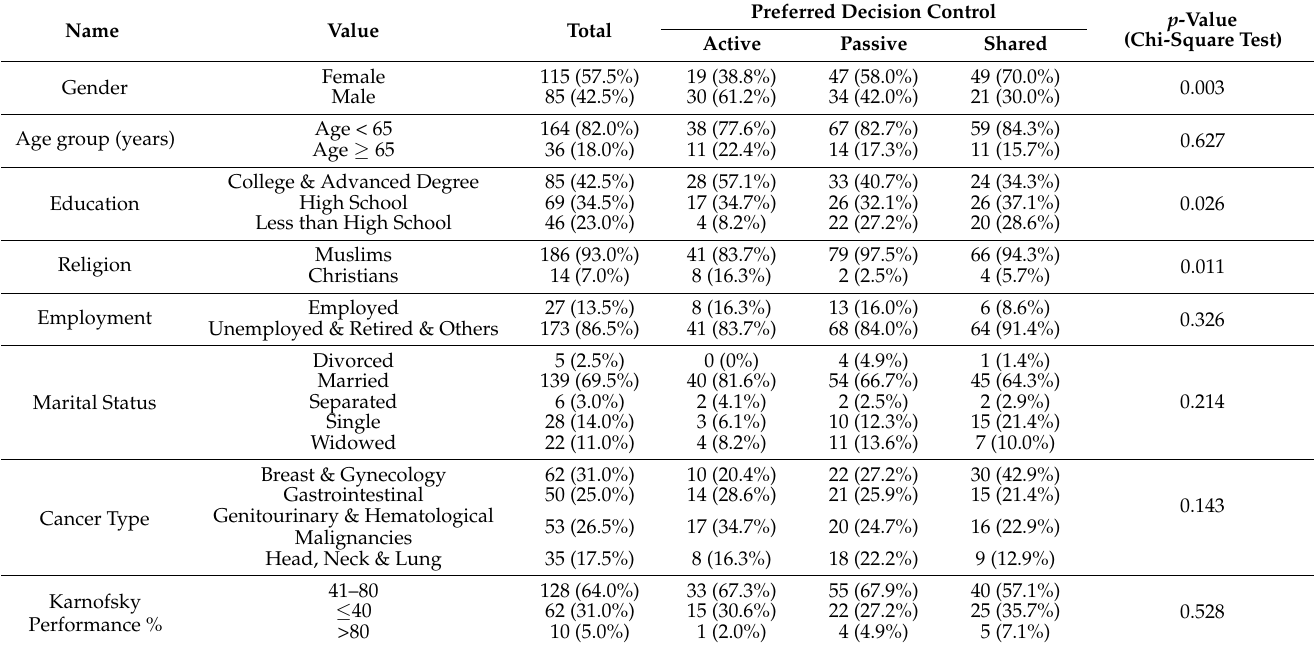
Table 4. Decision-control preferences based on patients’ characteristics ( n = 200).